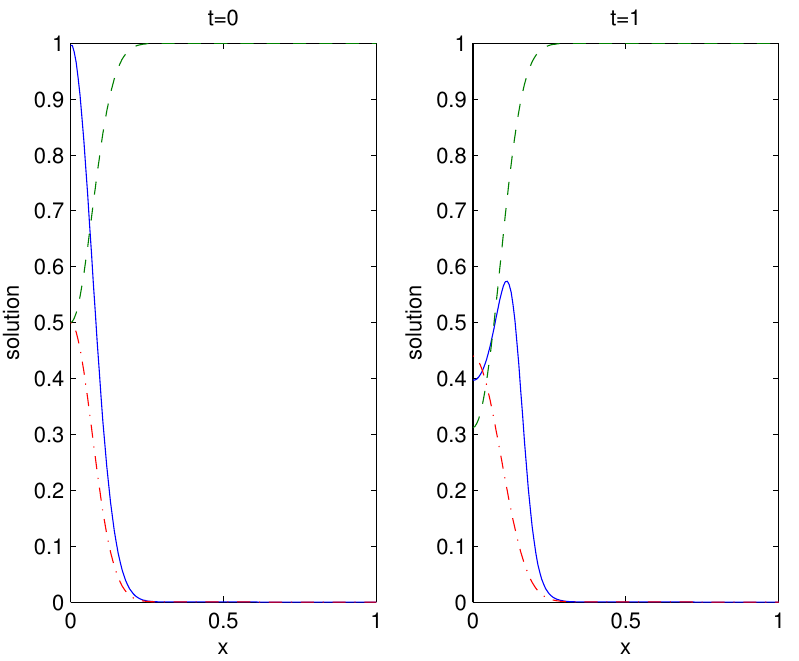
Figure 2. The solid line represents the density of cancer cells, the dashed line denotes the density of ECM, and the dashed and dotted line denotes the concentration of MDE at time t = 0 and t = 1. Solutions with the parameter value d n = 0.001, Example